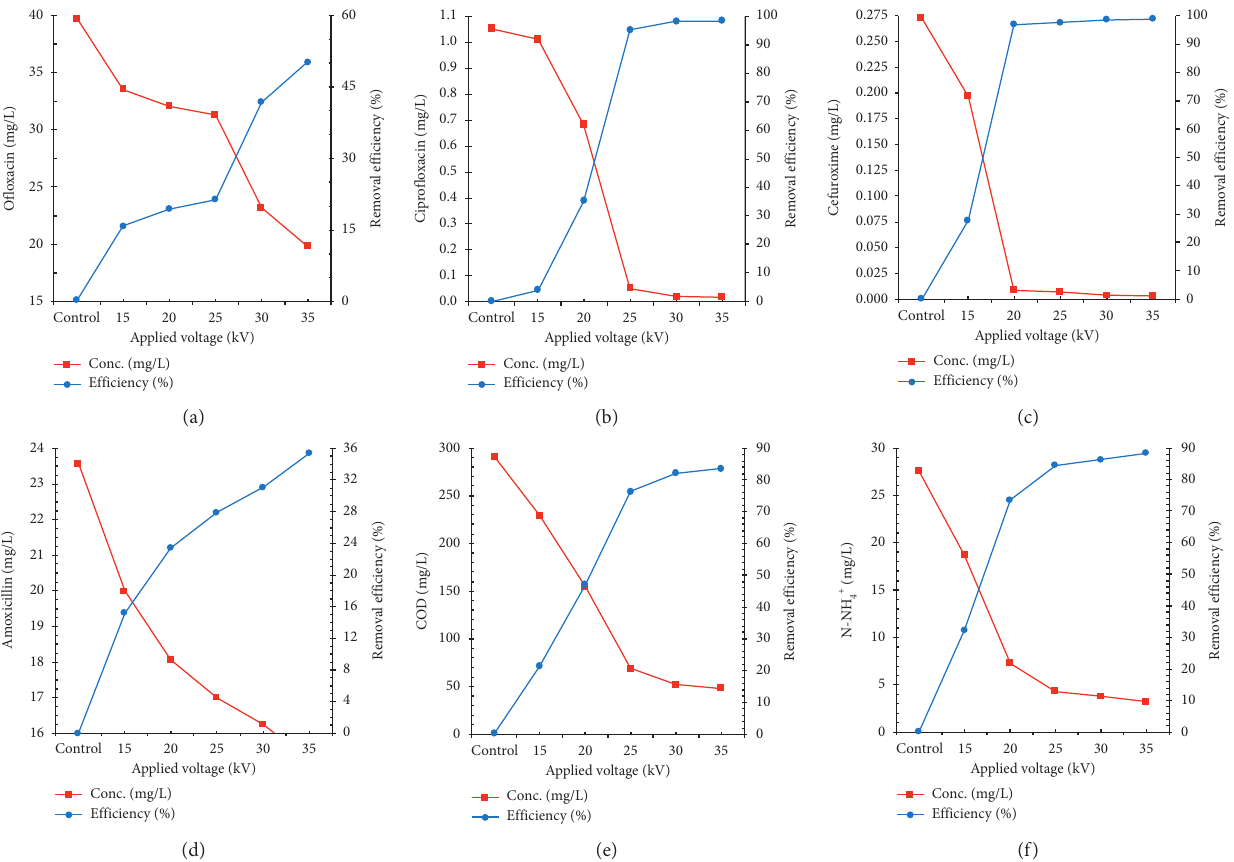
Figure 2: Effect of the applied voltage on the degradation efficiency of the four antibiotics, i.e., (a) ofloxacin, (b) ciprofloxacin, (c) cefuroxime, and (d) amoxicillin, respectively, as well as (e) COD and (f) ammonia